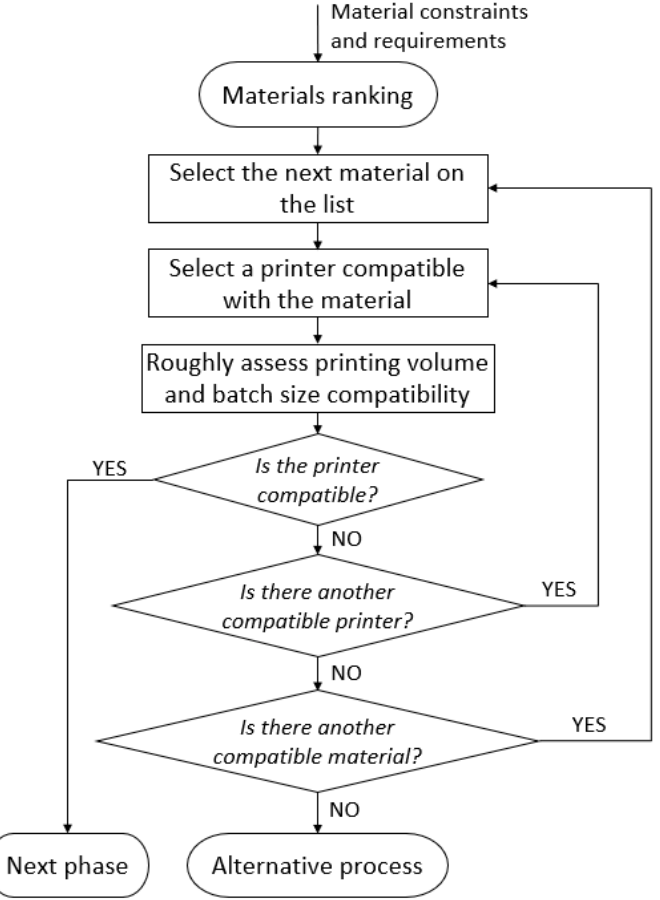
Figure 3. Workflow of the preliminary analysis of AM constraints.